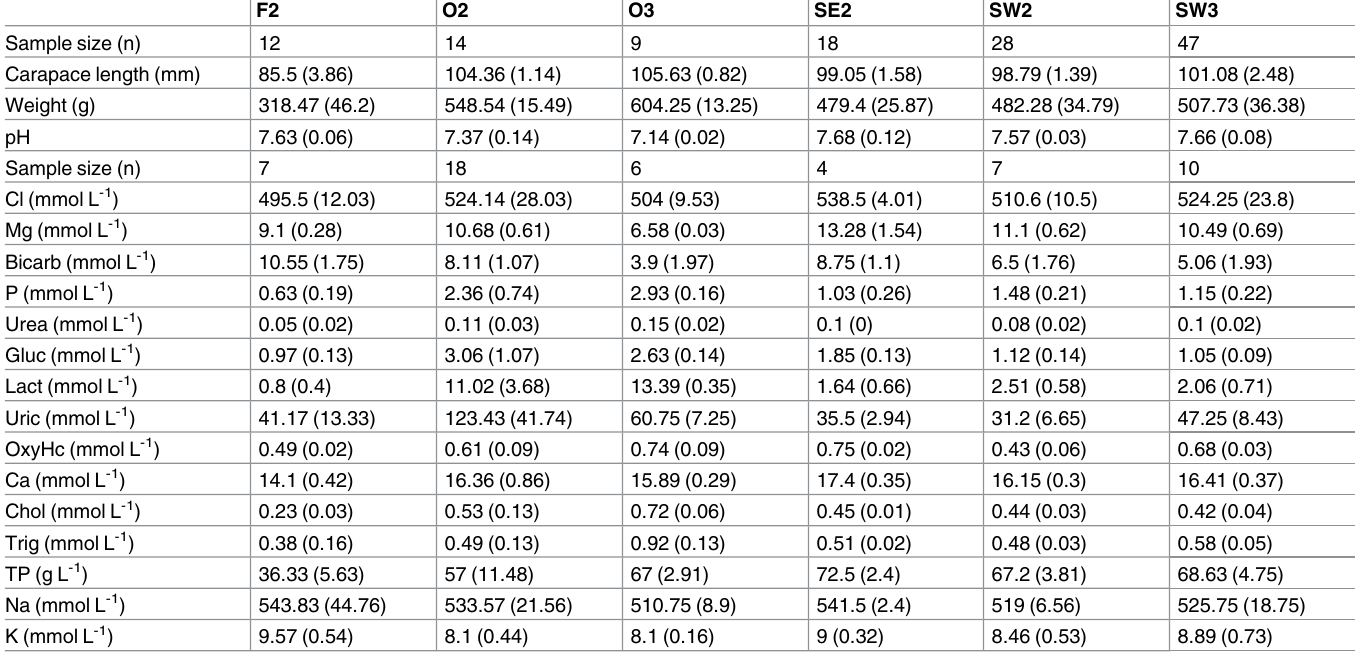
Table 2. Size, weight and biochemistry profiles of lobsters from different sites around Tasmania. Data are expressedas mean (SE). Note different sample sizes for haemolymphbiochemistry